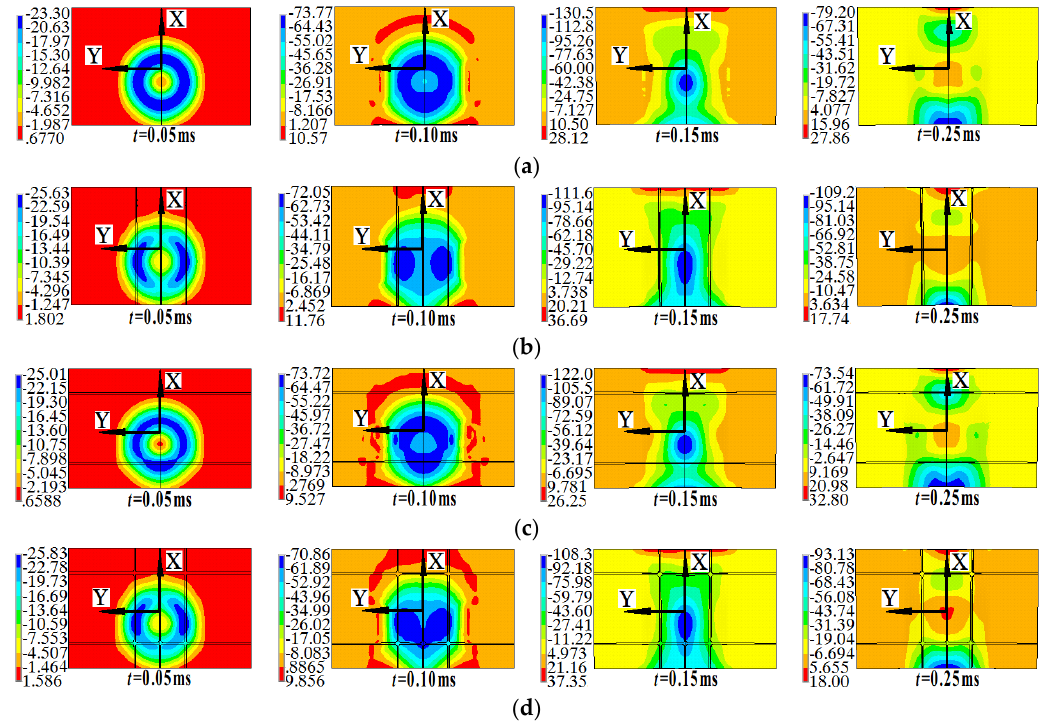
Figure 18. Z -velocity (m/s) distribution of: flat panel ( a ); X -rib panel ( b ); Y -rib panel ( c ); and grid-rib panel ( d ) during EMIF.